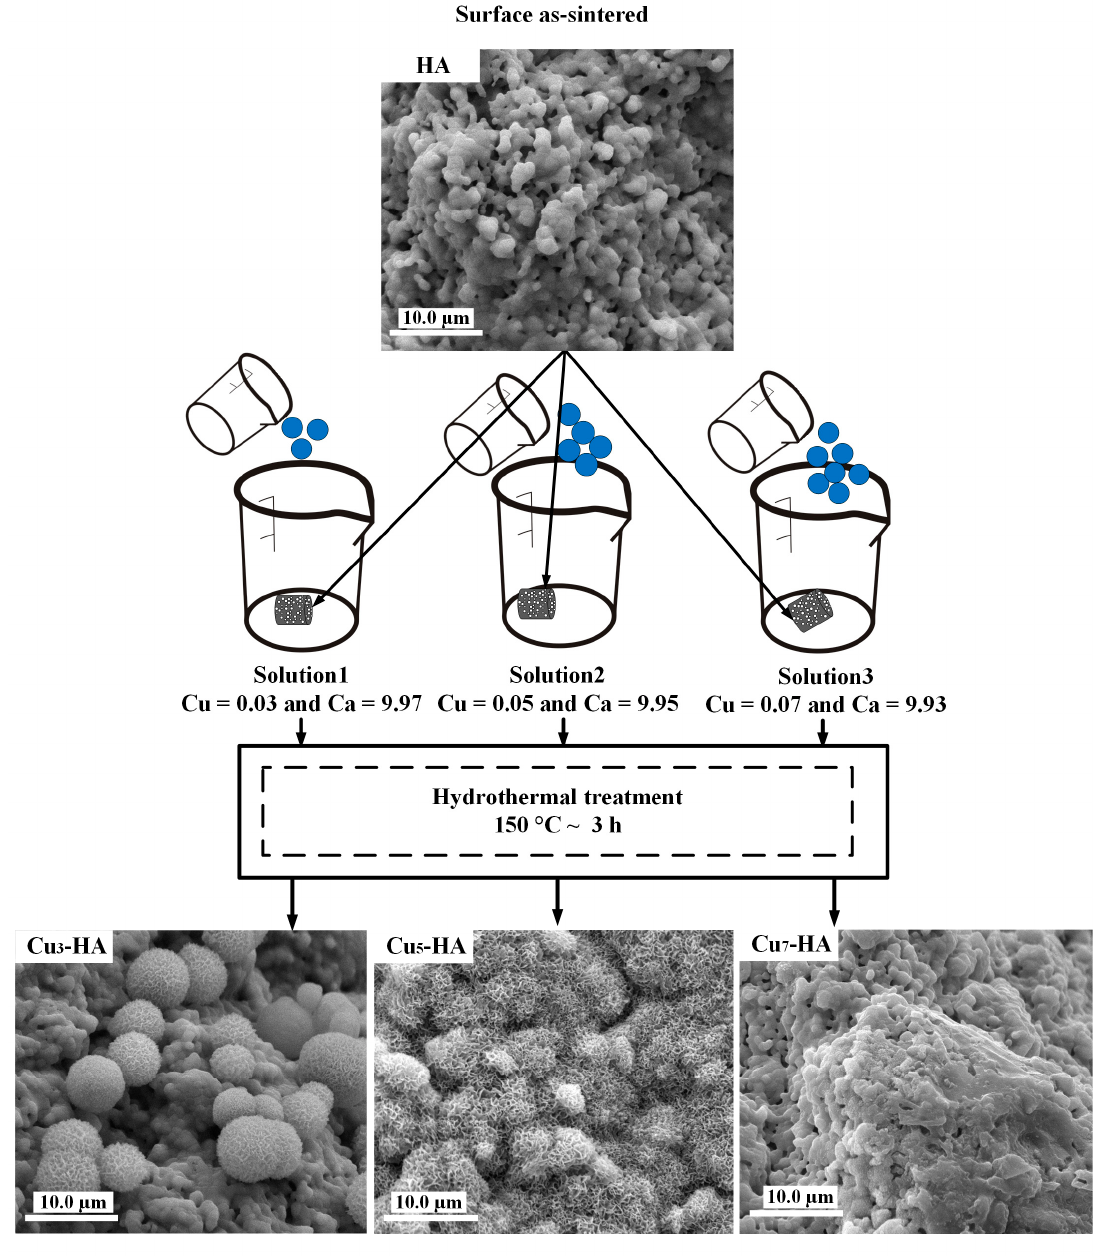
Figure 1. The experimental process used to hydrothermally construct the micro-nano-structured surface on hydroxyapatite (HA) fiber scaffolds.